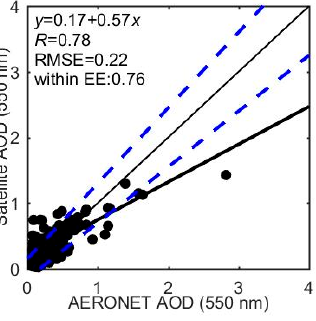
Figure 18. The conventional AVHRR AOD retrieval at 0.55 μ m using 0.63 μ m channel versus the AERONET AOD measurement at 0.55 μ m. The narrow solid line is the 1:1 line. The bold solid line depicts the regressed line. The error lines (±0.15 ± 0.15 𝜏 ) are also shown (dashed blue lines). The text describes the linear regression relationship, 𝑅 , RMSE error, and ratio within the error lines.